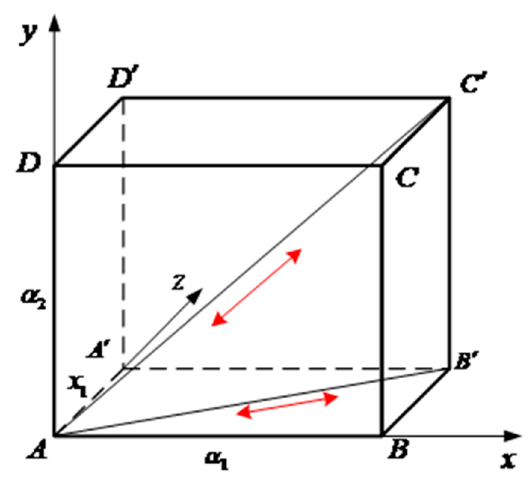
Figure 5. A schematic diagram of dimension expansion of the EM.